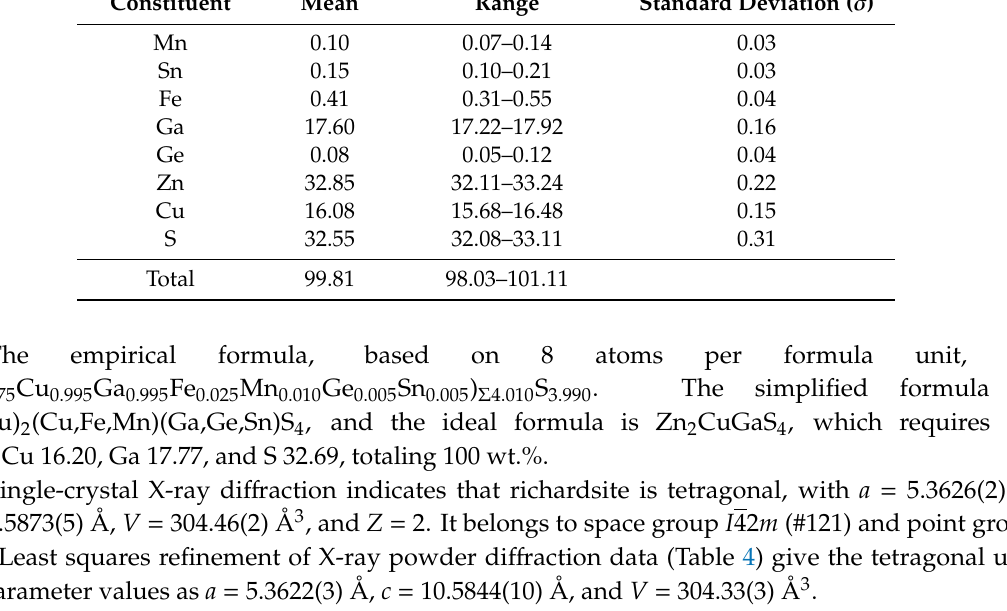
Table 3. Electron microprobe data (means and ranges in wt.% of elements) for richardsite.